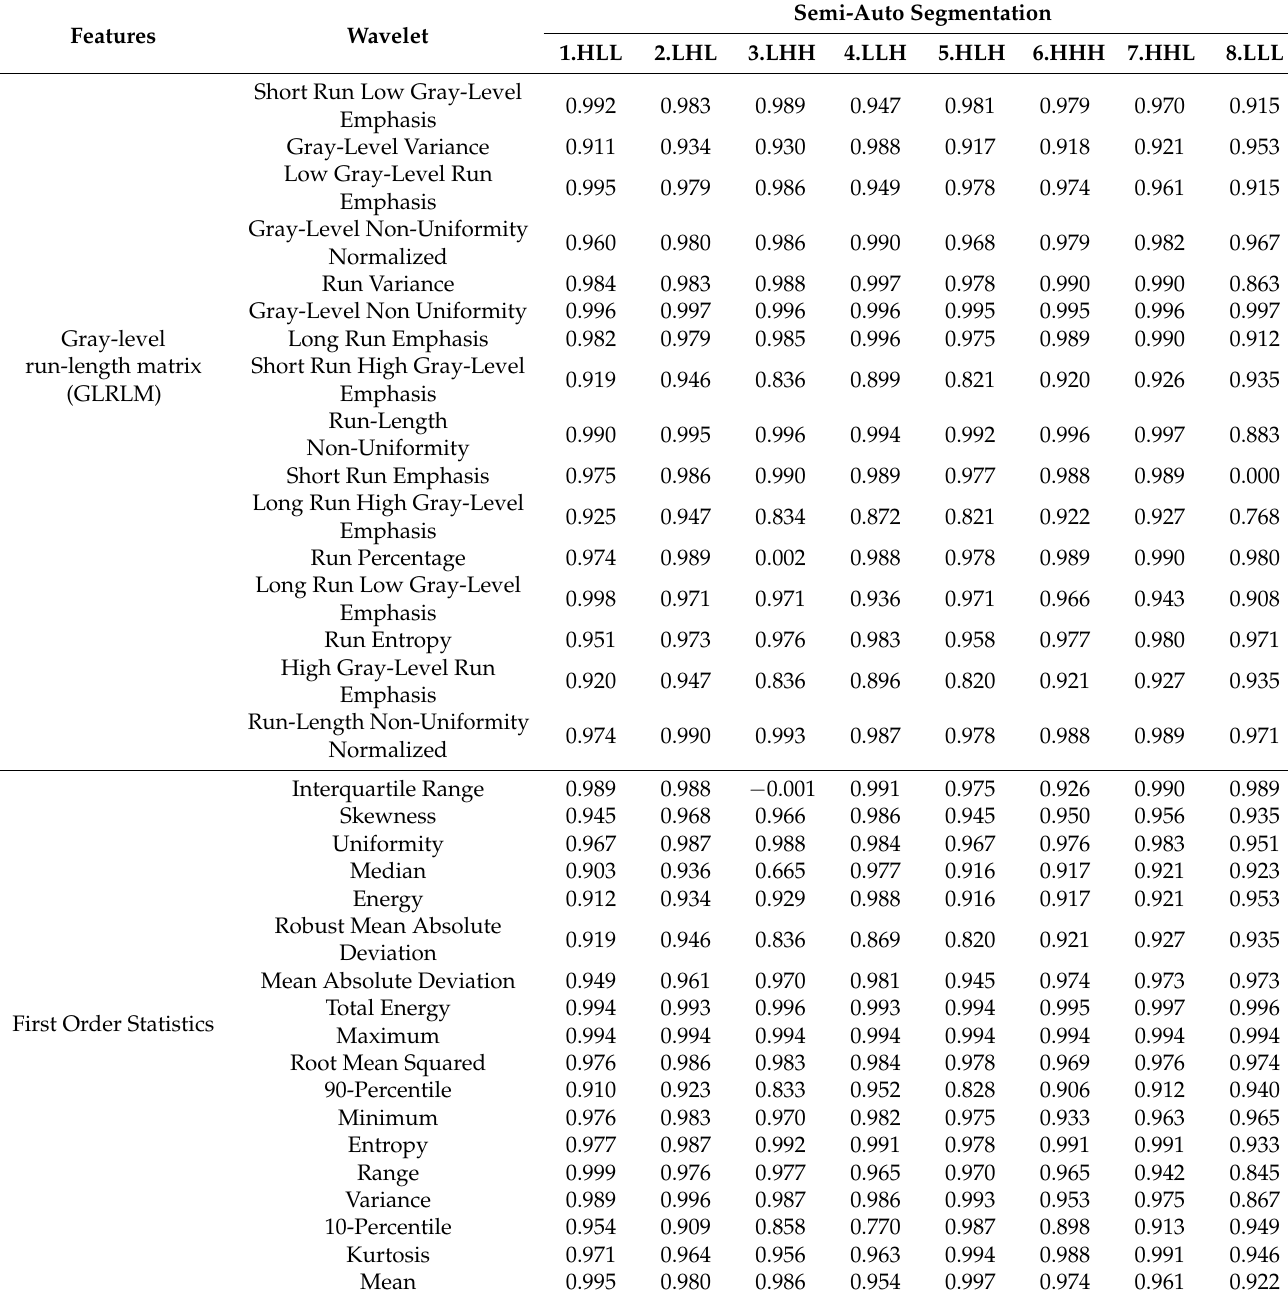
Table 3. Wavelet features for semi-automatic